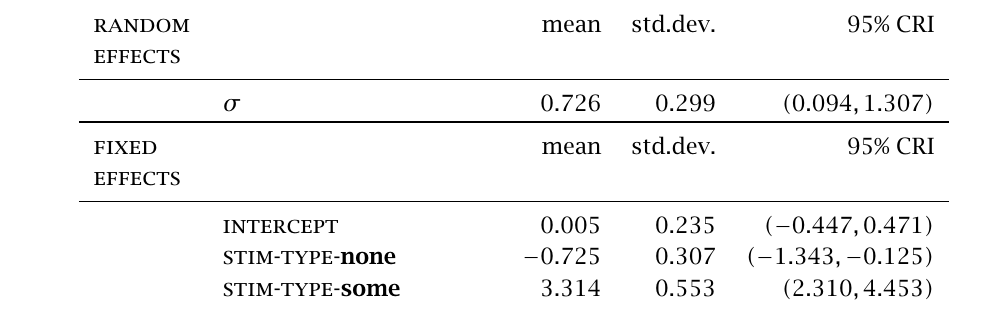
Experiment 2 : Posterior means, standard deviations and 95 % CRIs for the estimated mixed-effects logistic regression